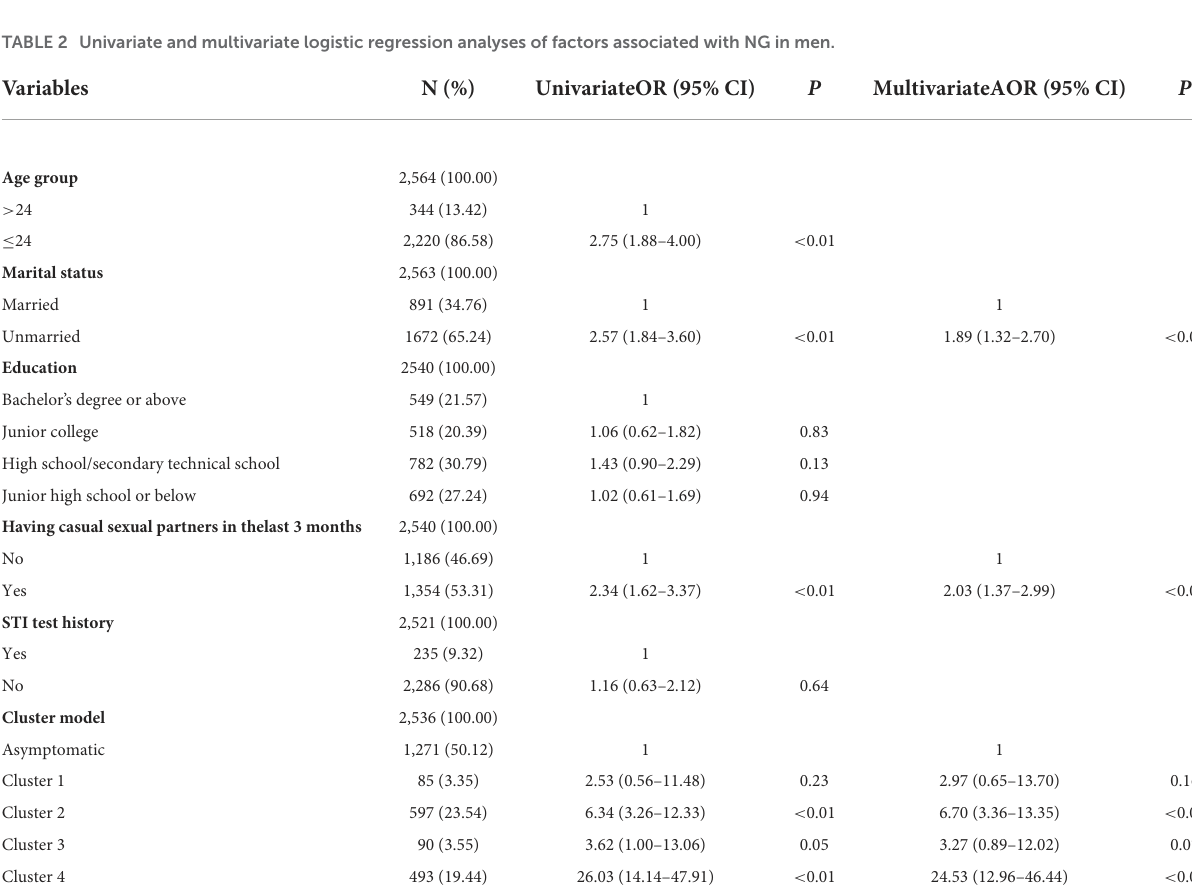
TABLE 2 Univariate and multivariate logistic regression analyses of factors associated with NG in